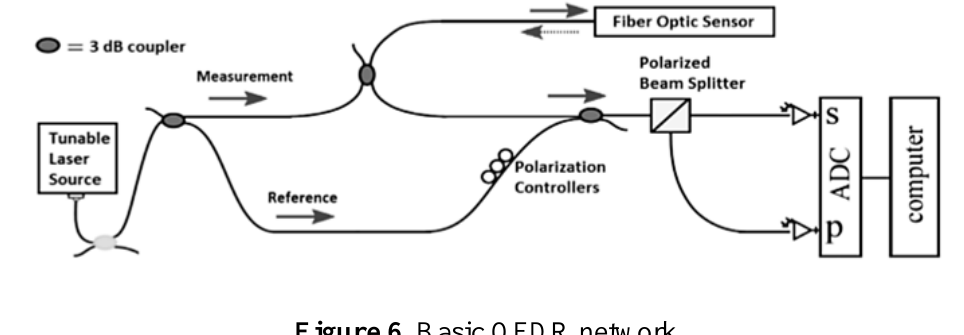
Figure 6. Basic OFDR